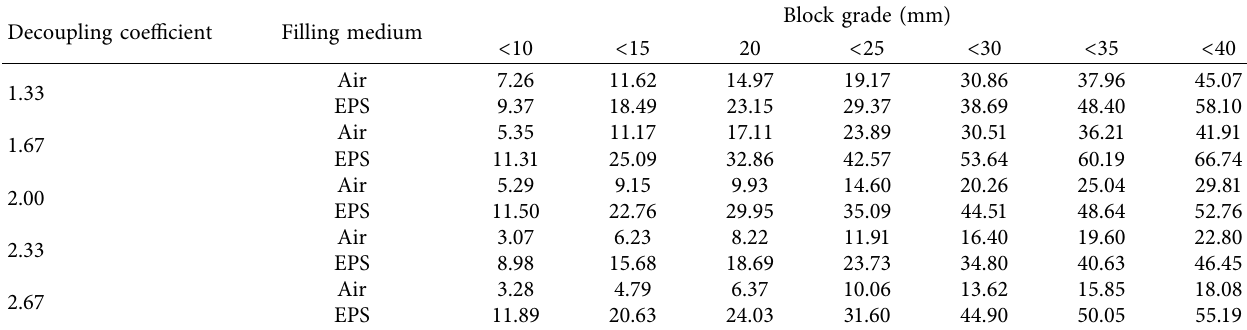
Table 7: Distribution of gravel lumpiness after blasting